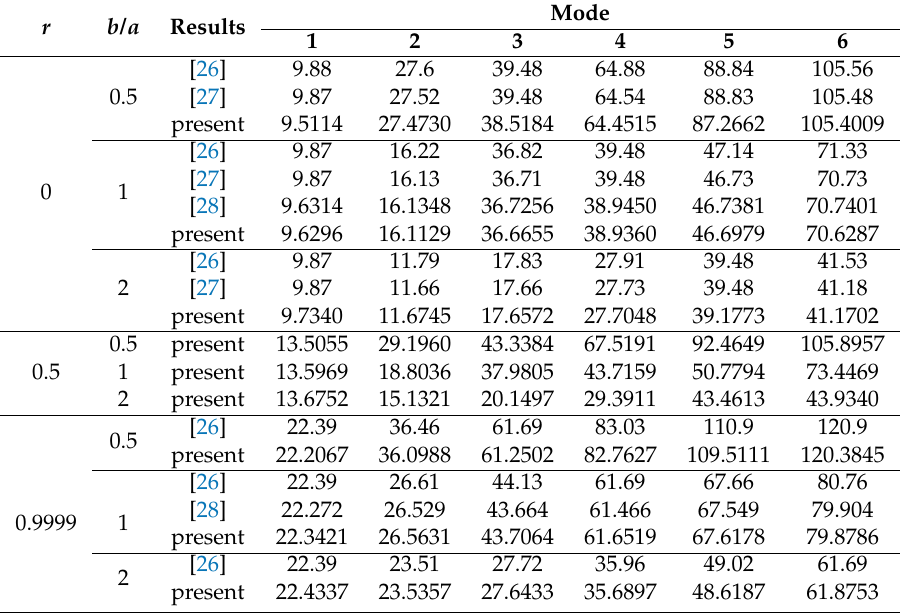
(cid:112) ρ h / D for isotropic plates with three different